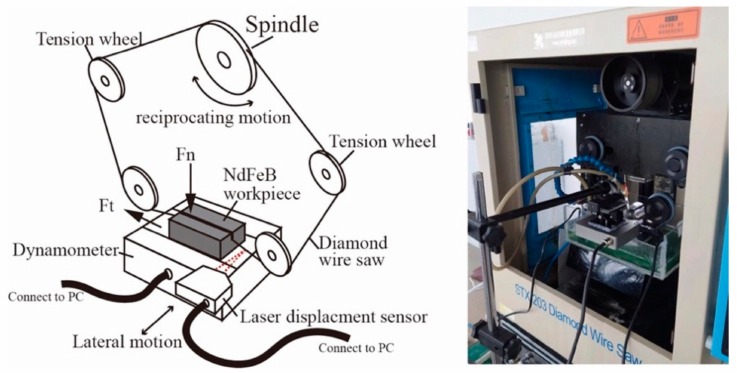
Figure 1. The experimental setup for all of the diamond wire sawing experiments.